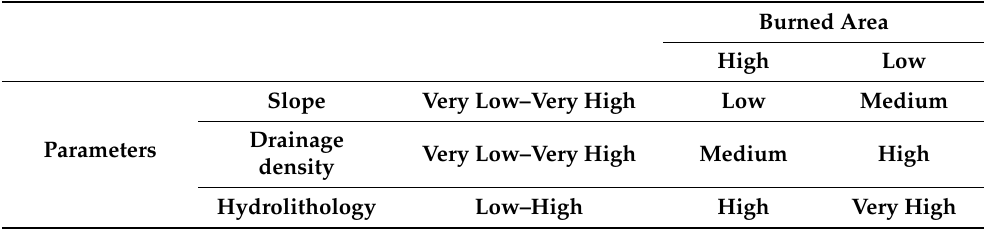
Table 1. Parameters used for the assessment of flash flood hazard and their relationships. The background color follows the color plate of the map: green (low hazard), yellow (medium hazard), orange (high hazard) and red (very high